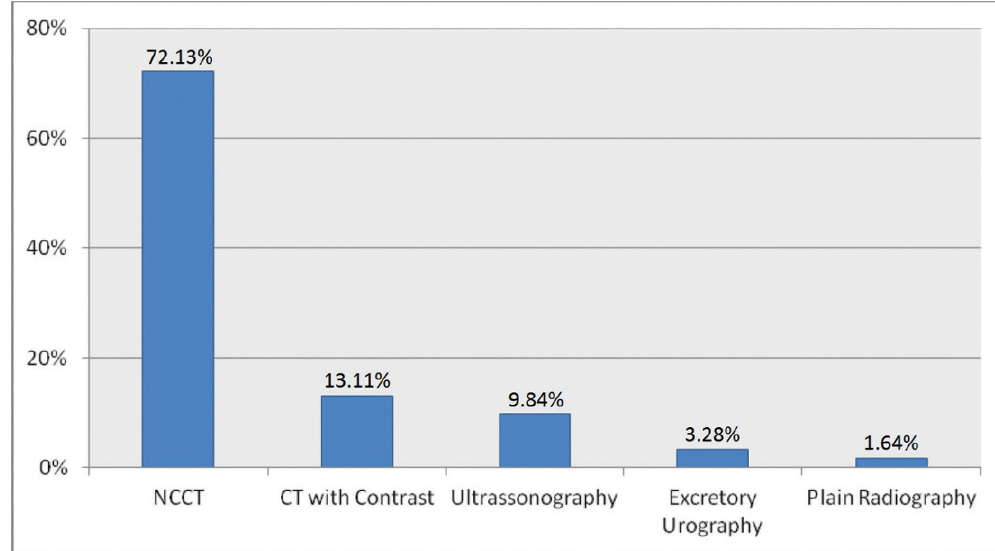
Figure 1 - Primary radiological exam requested by the attending physician for patients with